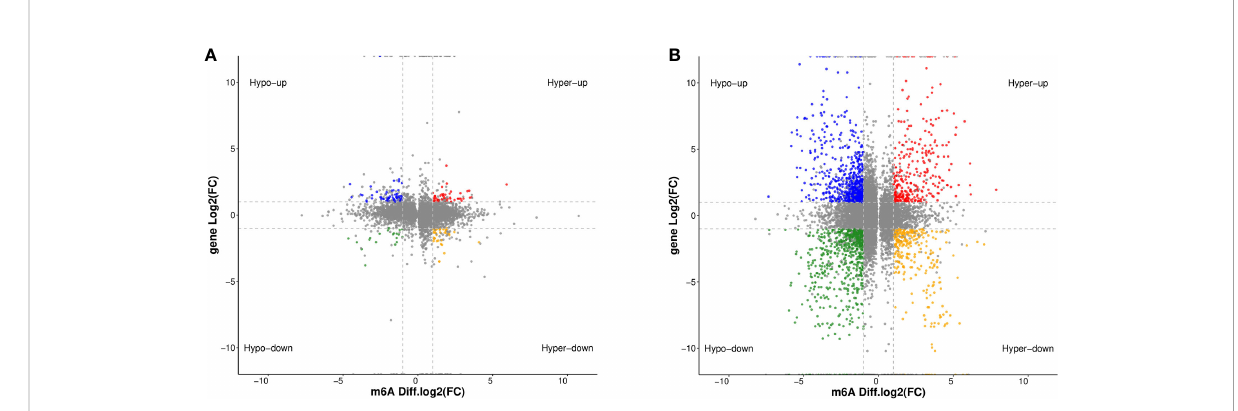
FIGURE 5 Distribution of differentially expressed genes with differential m 6 A peaks in DOK and SCC-9 cells, compared with HOEC cells. (A) HOEC VS DOK; (B) HOEC VS SCC-9. Hyper-up, m 6 A peak upregulated and mRNA expression upregulated; Hyper-down, m 6 A peak upregulated and mRNA expression downregulated; Hypo-up, m 6 A peak downregulated and mRNA expression upregulated; Hypo-down, m 6 A peak downregulated and mRNA expression